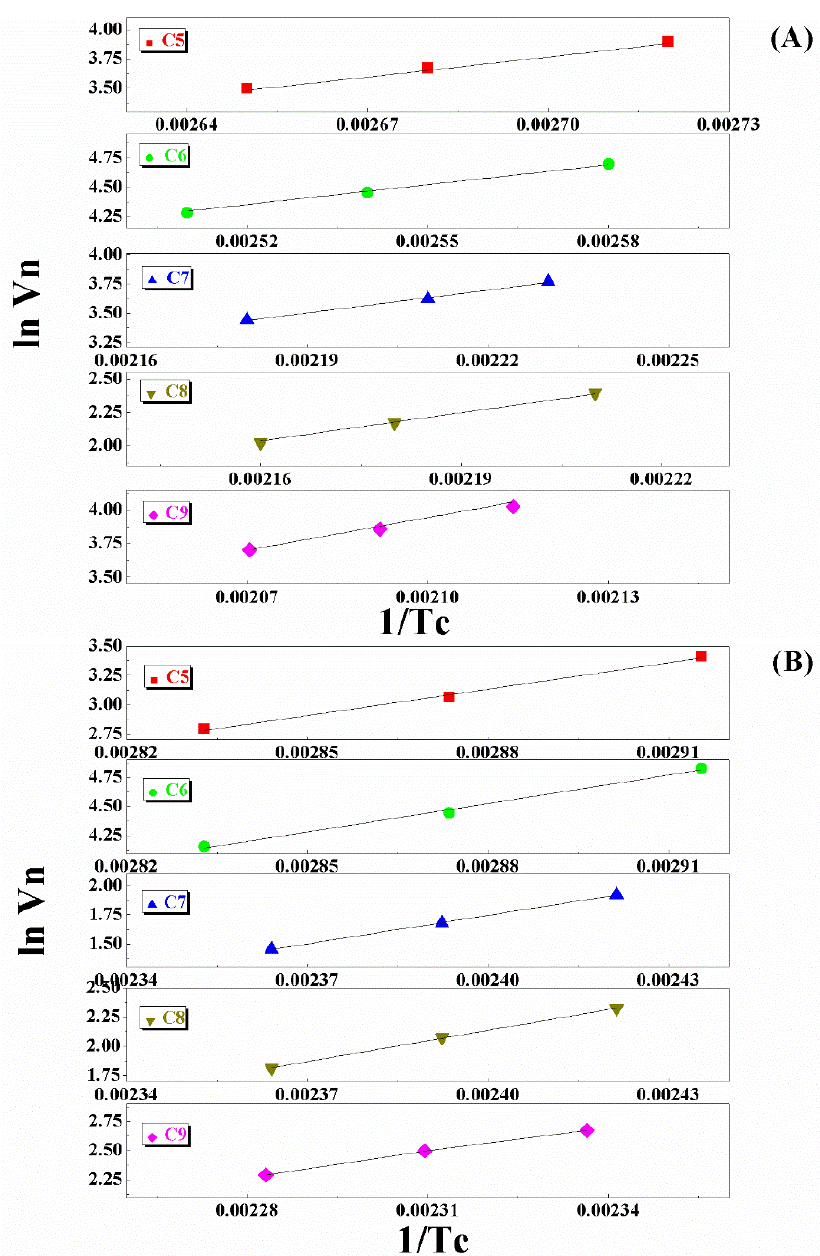
Figure 6. Ln Vn vs. 1/Tc representation by C 5 –C 9 in ( A ) volcanic glass and ( B ) Cu 2+ -volcanic glass. Table 4. Fitting parameters of the adsorption isotherms of C 5 –C 9 on volcanic glass and Cu 2+ -volcanic glass at 273 K.